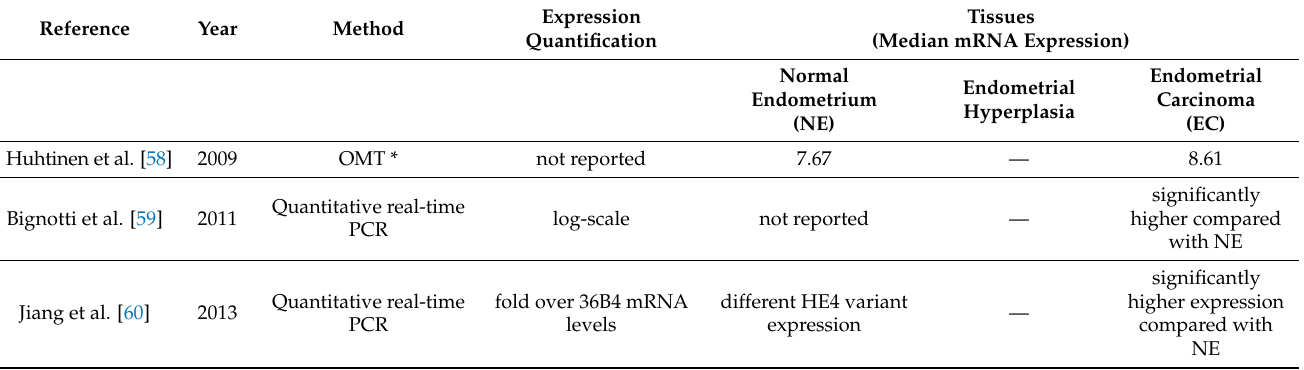
Table 2. Characteristics of three studies measuring HE4 tissue mRNA